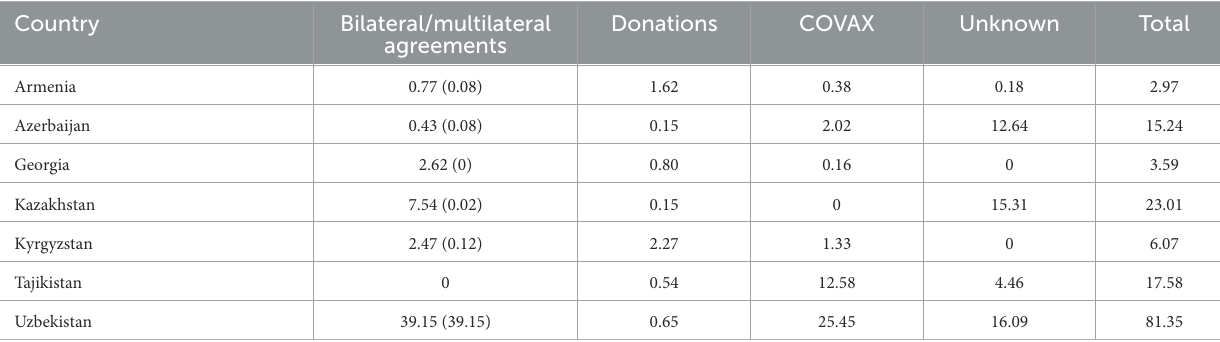
TABLE 1 Source of COVID-19 vaccines administered in 7 countries in Central and West Asia.